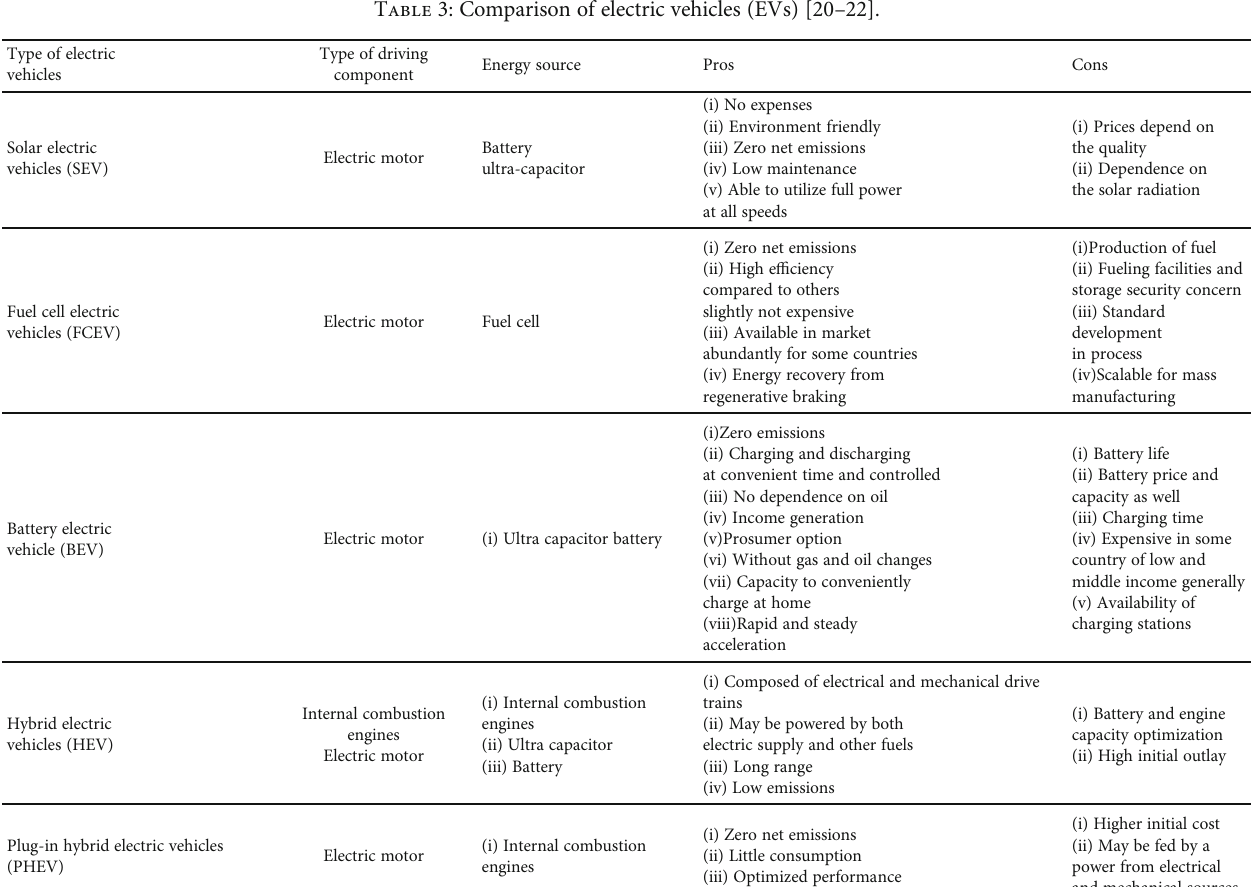
Table 3: Comparison of electric vehicles (EVs) [20 –